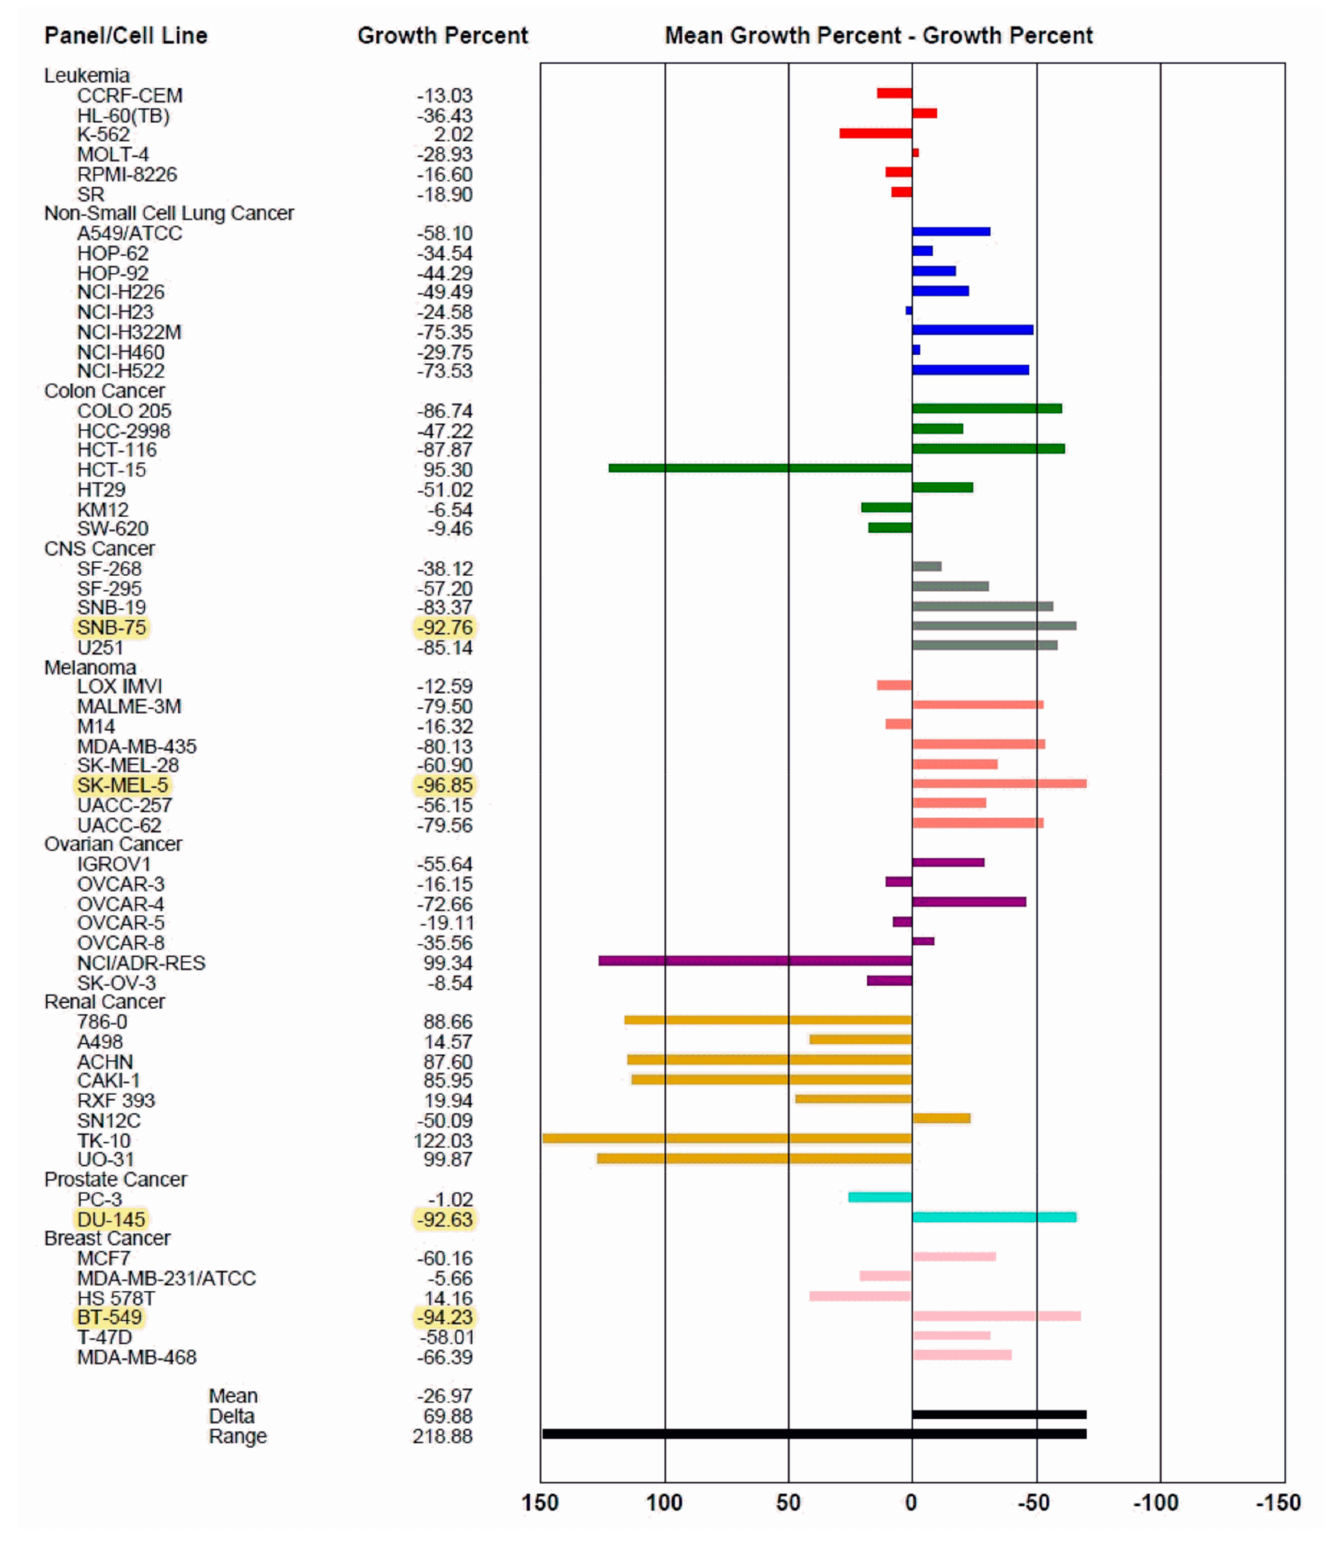
Figure 2. The mean graph of the one-dose (10 µ M) screen of MS47 (NSC778438) illustrates the sensitivity of the sixty human tumor cell lines to the cytotoxic activity of MS47 . Yellow highlights represent the most sensitive cell lines to MS47 cytotoxic (lethal) activity and their PG values in the range of